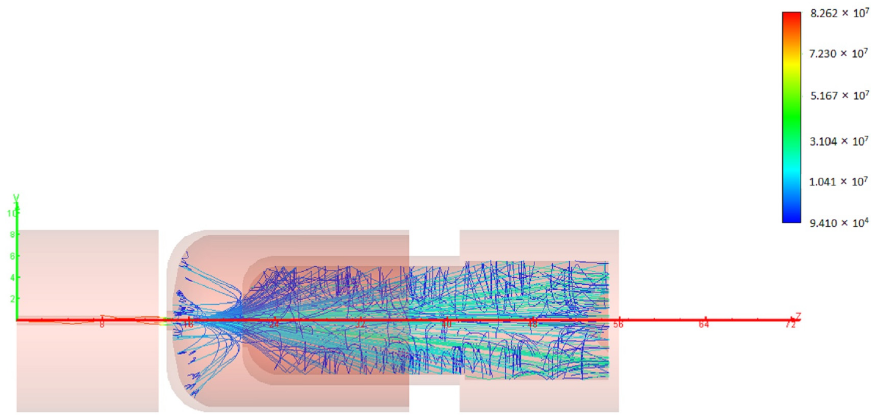
Table 2. The simulation results of different frequency.